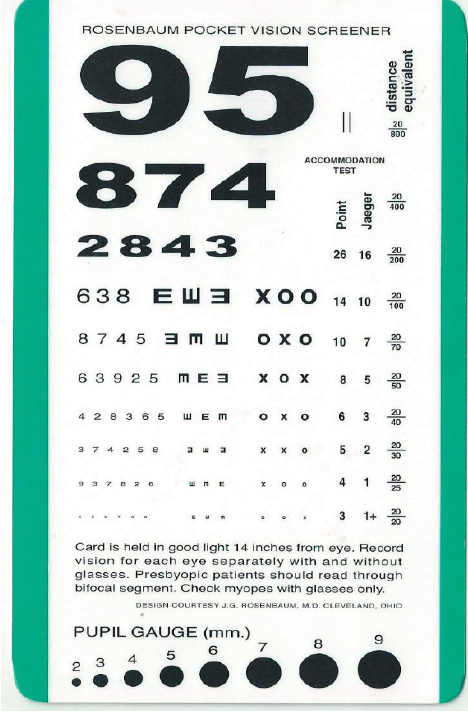
Figure 3. The portable Rosenbaum pocket vision screener is extensively used in clinics to evaluate vision in immobile or sick patients or when the test distance is